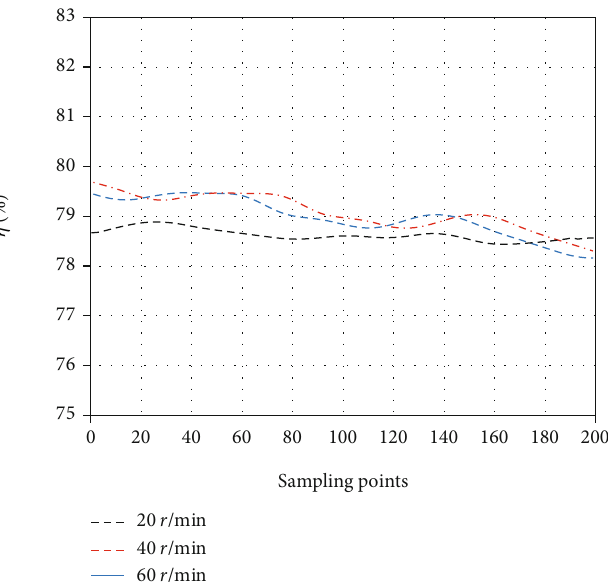
Figure 15: The variation of e ffi ciencies with various velocities of